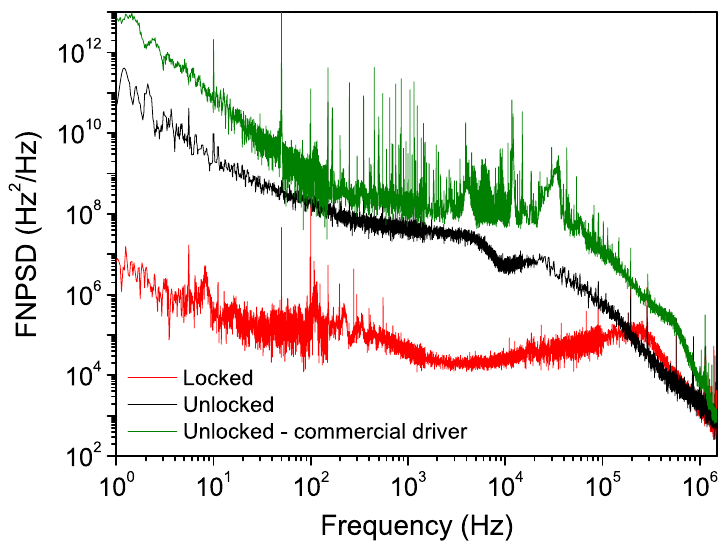
Figure 4. Frequency noise spectral power density of the laser in both free-running and locking conditions (black and red traces). The FNPSD with the laser operated with a commercial driver is also shown for comparison (green